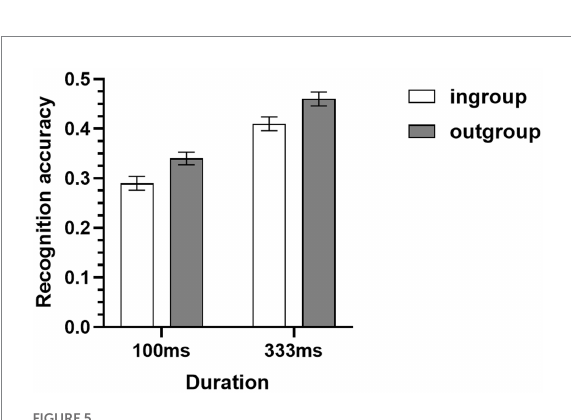
FIGURE 5 Mean recognition accuracies of micro-expressions of ingroup and outgroup members in Study 2A. Error bars represent standard